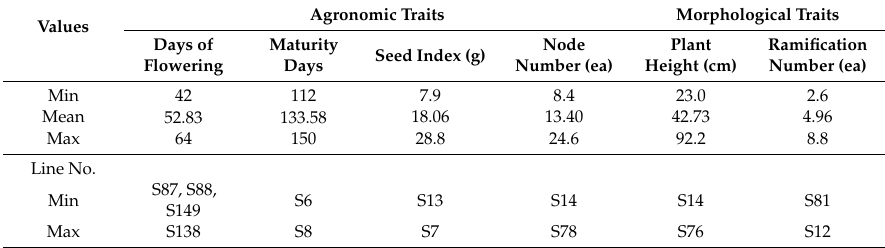
Table 2. Summary of quantitative trait values in 208 soybean MDP lines.